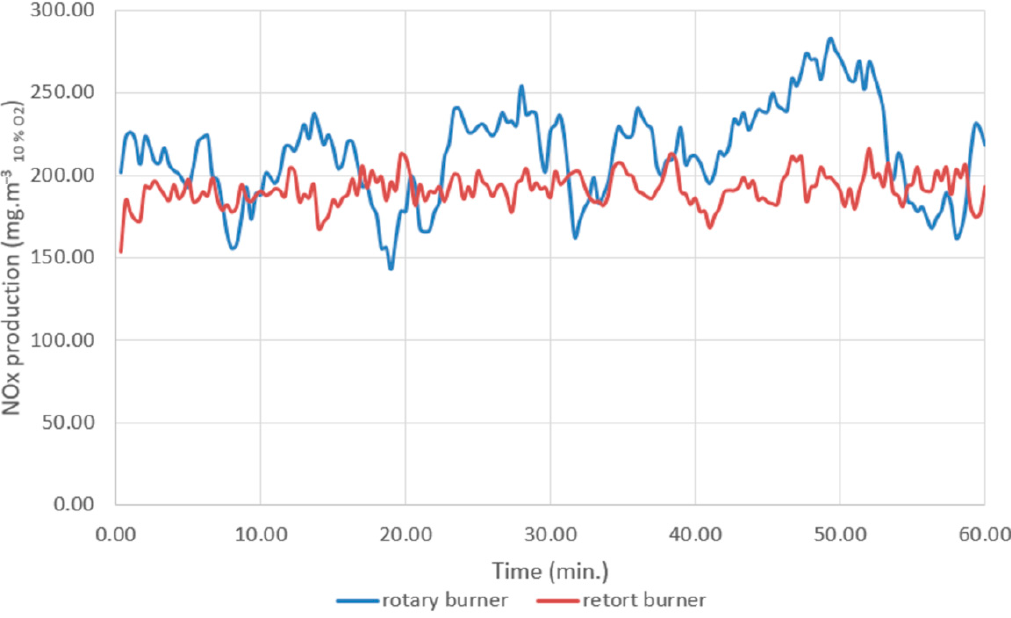
Figure 8. Typical time courses of NOx emissions depending on the type of burner from experiments.